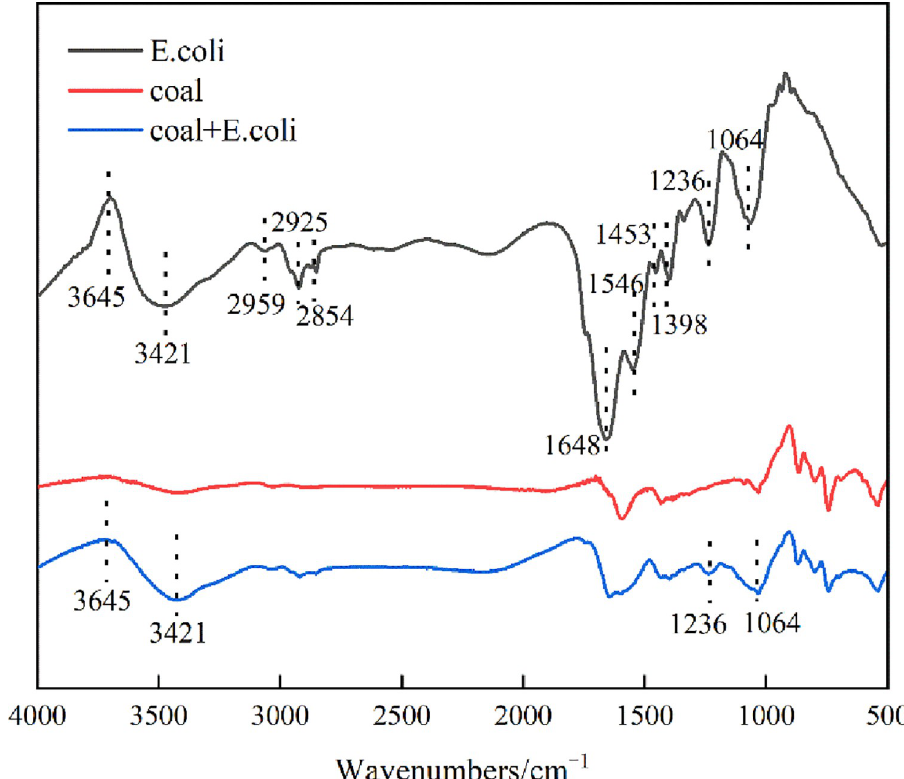
Fig 6. FTIR of coal and E . coli before and after their